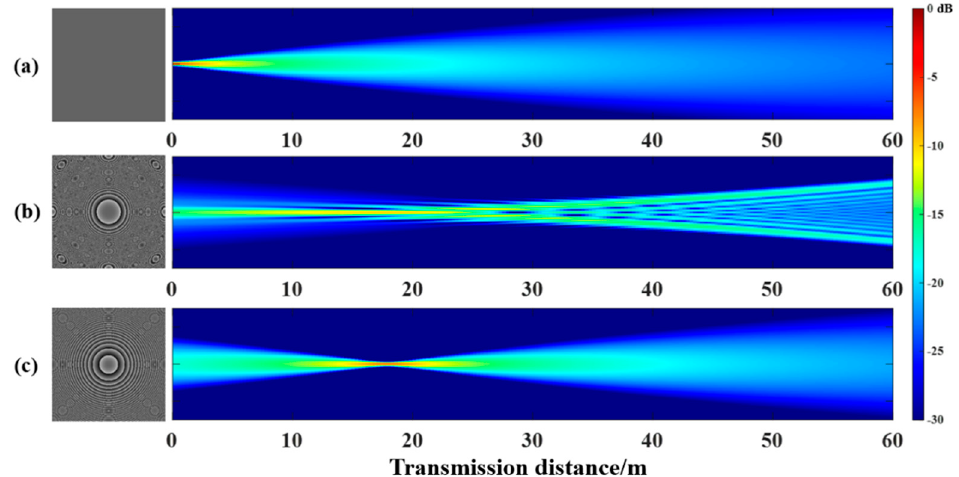
Figure 3. The phase holograms and simulated characteristics of the launched beams ( a ) without shaping; ( b ) with the cubic modulation beam shaping when b = 4.95 × 10 11 ; ( c ) with the Fresnel modulation beam shaping when b = 1.25 × 10 8 .